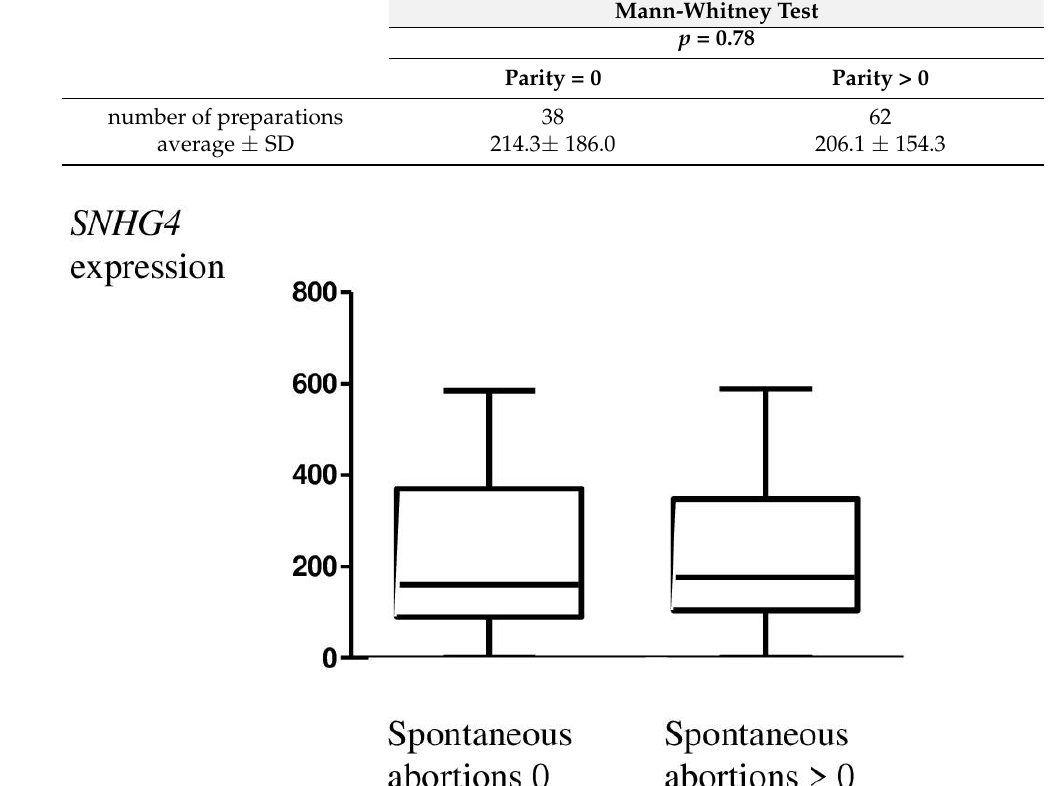
Figure 4. Relative expression of the SNHG4 gene in relation to the number of spontaneous abortions (Mann – Whitney test; p = 0.68).